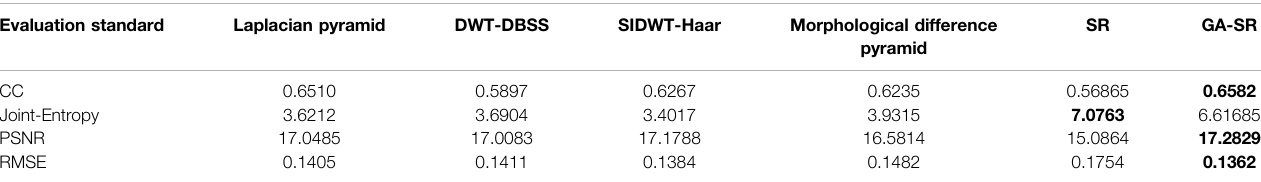
TABLE 4 | Quality evaluation of fused images of the fourth